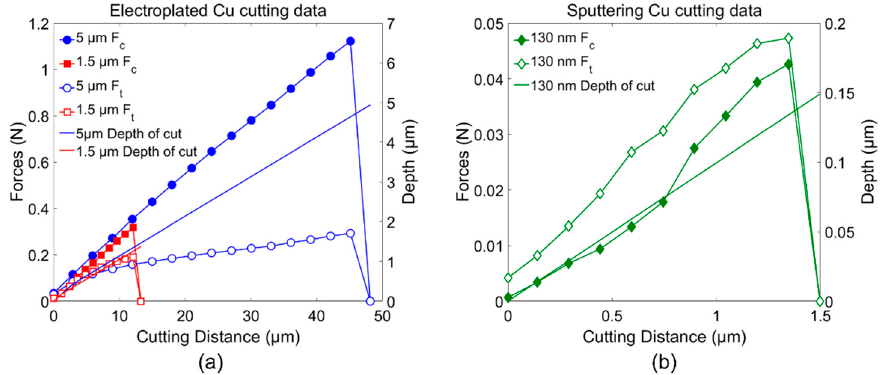
Figure 3. Cutting data for Cu thin films: ( a ) 1.5 μ m and 5 μ m electroplating cutting; ( b ) 130 nm sputtering cutting.